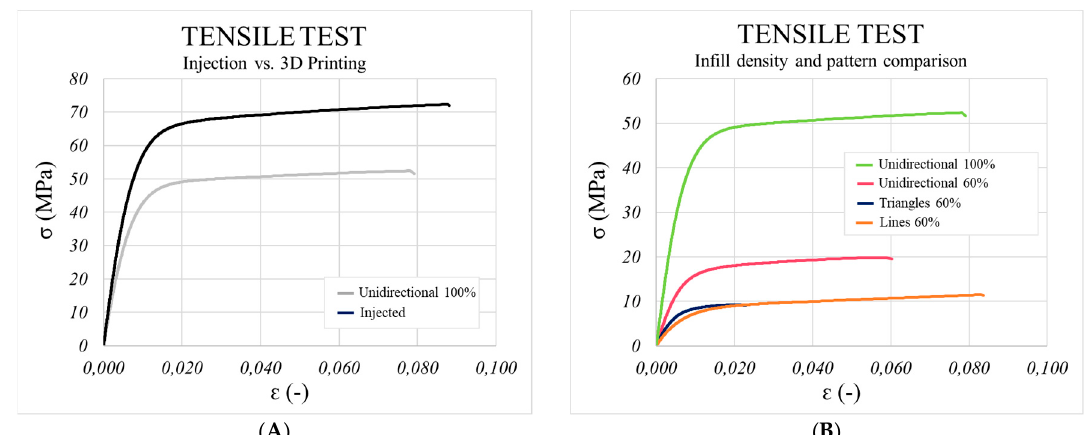
Figure 7. Comparison of the behaviour of the injected and printed samples with stretching stresses in the tensile test ( A ), and the influence of infill density and printing pattern on the mechanical behaviour of the printed parts ( B ).